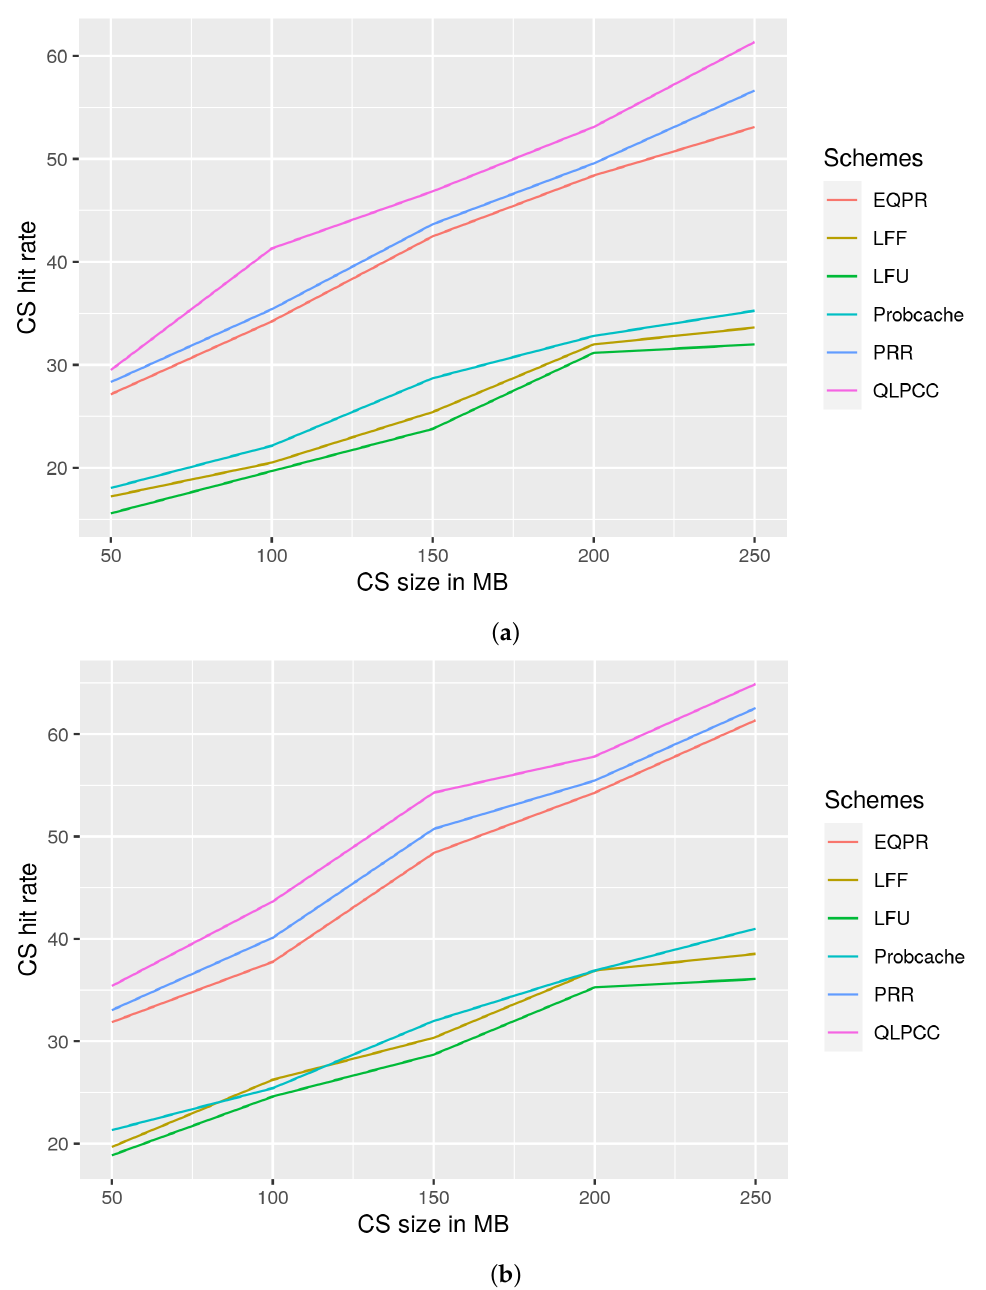
Figure 5. Content store size vs. hit rate for QoS traffic. ( a ) Content store size vs. hit rate (QoS traffic) for | M | = 500. ( b ) Content store size vs. hit rate (QoS traffic) for | M | =